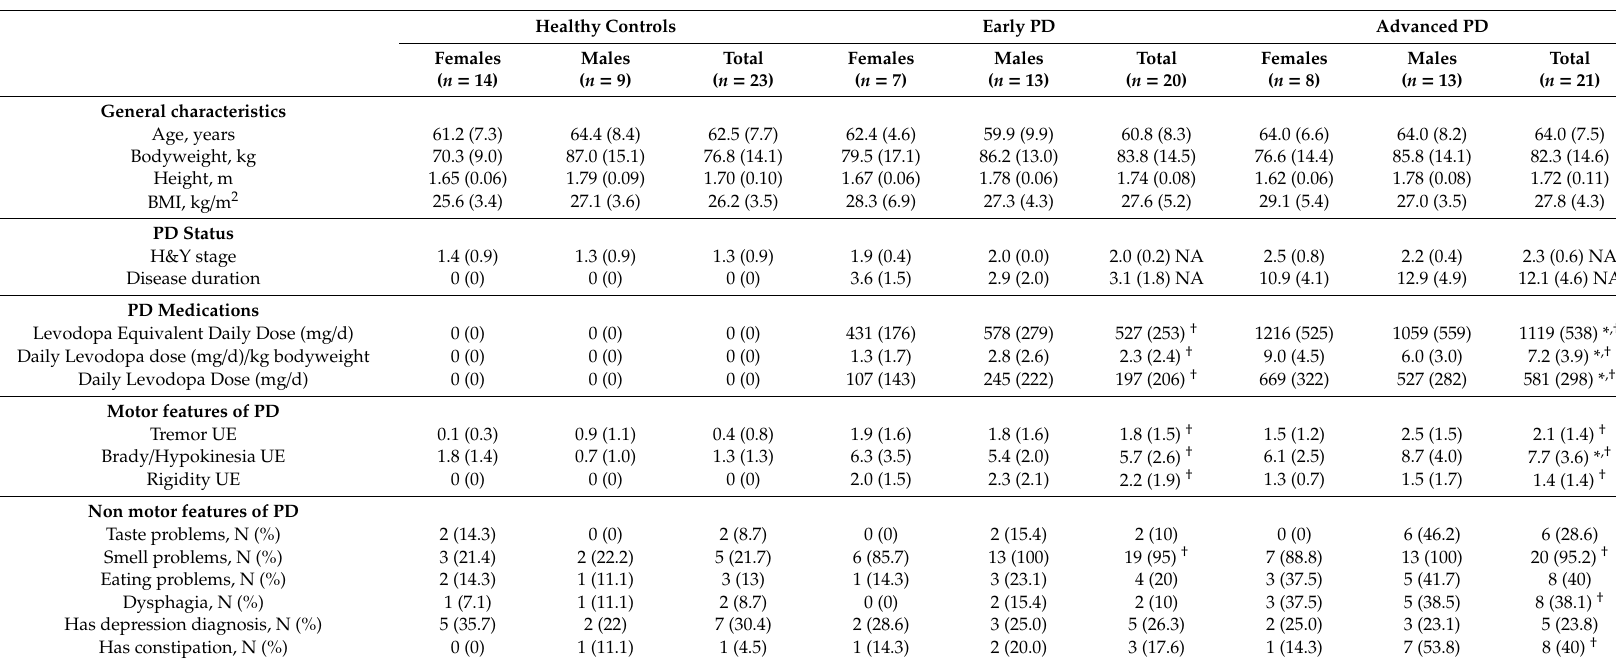
Table 2. Mean (standard deviation) characteristics of the three groups of (1) healthy controls, (2) early Parkinson’s disease (PD), and (3) advanced PD patients. Data are shown for females, males and total group